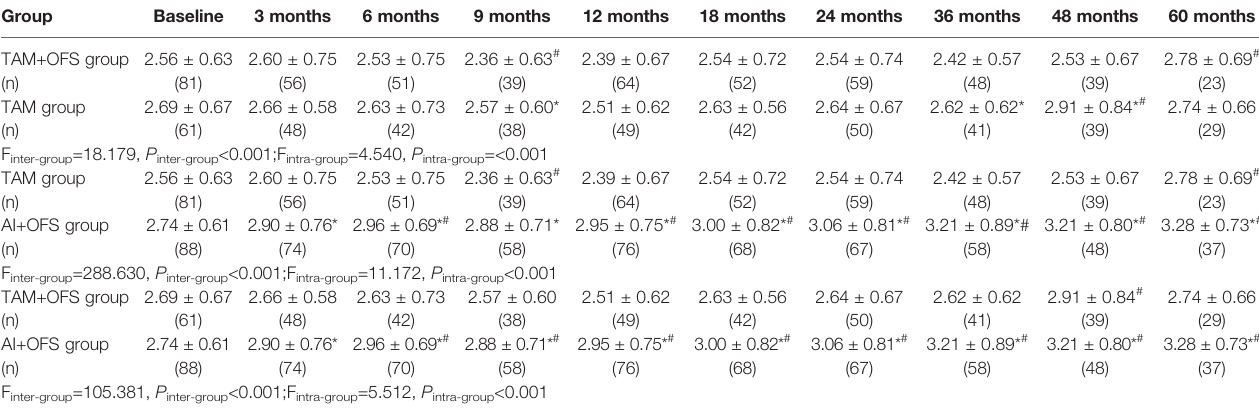
TABLE 7 | Comparison of low-density lipoprotein cholesterol (LDL-C) level at different time-points over the course of treatment. Group Baseline